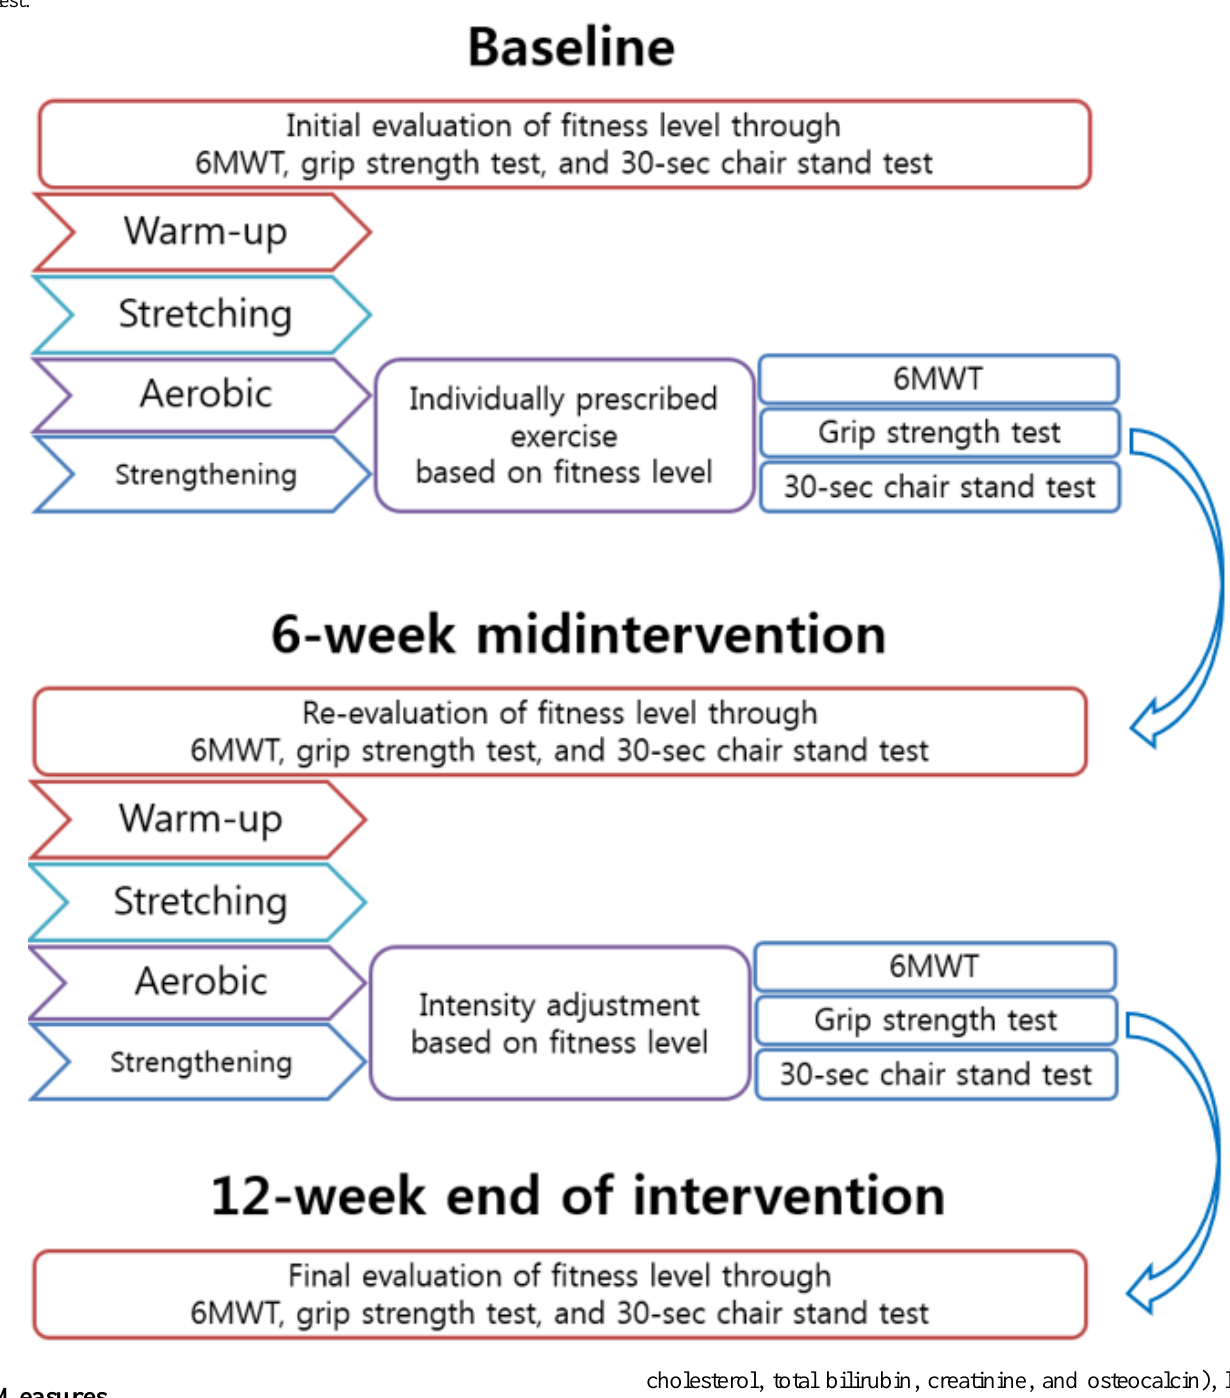
Figure 2. Procedure for adjusting participants' individually prescribed rehabilitation exercise programs in the mHealth app. 6MWT: 6-minute walk